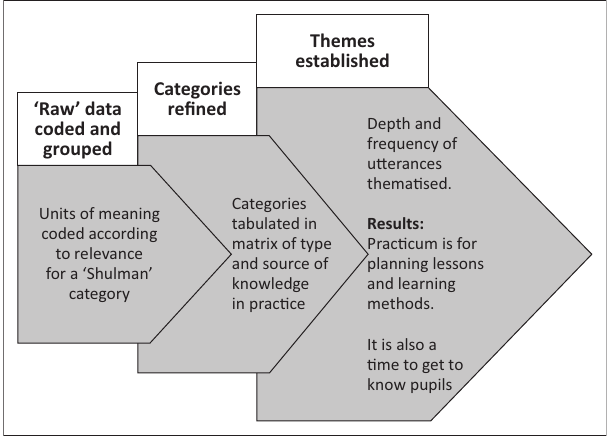
FIGURE 1: Analysis of interview